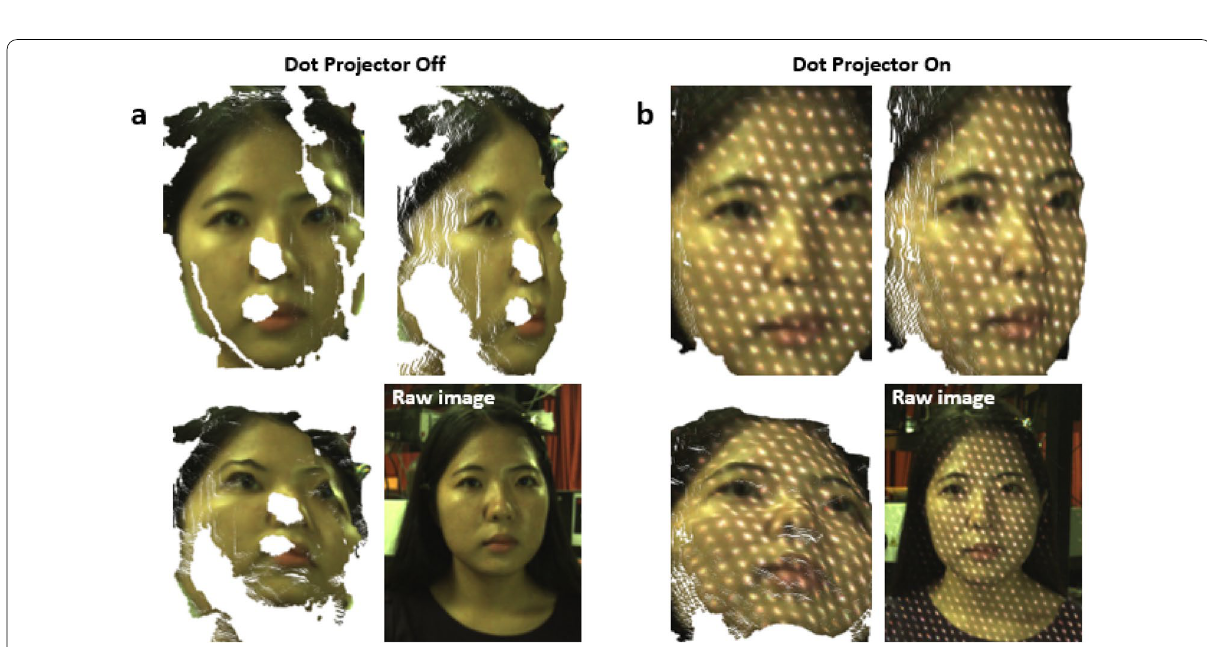
Fig. 3 3D point cloud reconstruction obtained from the FRCM. a 3D face imaging without dotprojection often results in incorrect stereo matching. Depth informationacquisition fails or is obtained incorrectly in some parts of a non‑texturedsurface. b Dot projection enhances the stereo matching results on